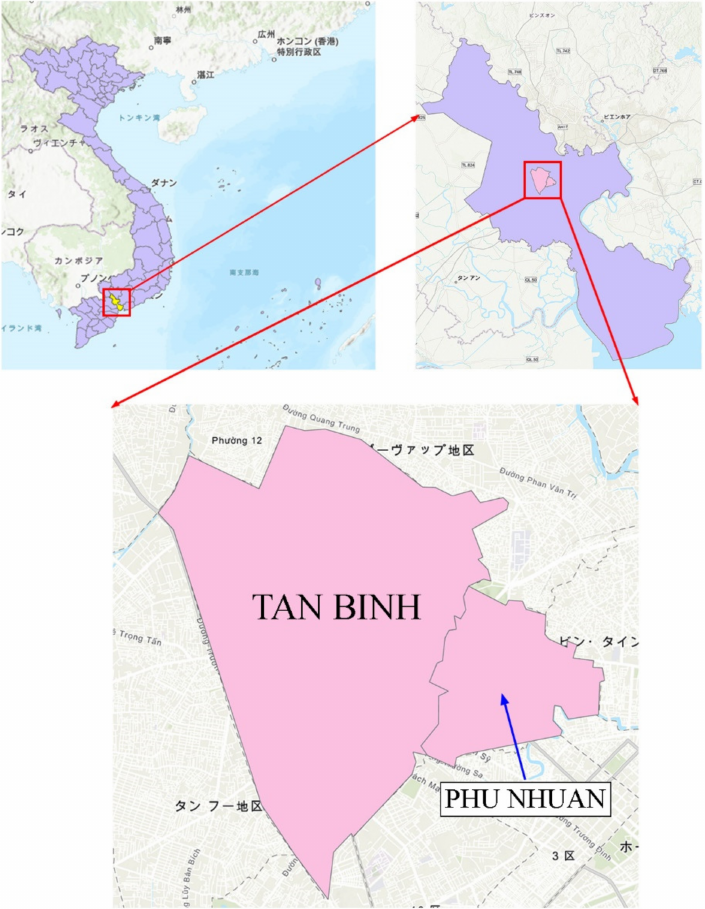
Figure 2. The Tan Binh and Phu Nhuan districts are located in central Ho Chi Minh City, Vietnam. The locations’ Japanese names come along with English